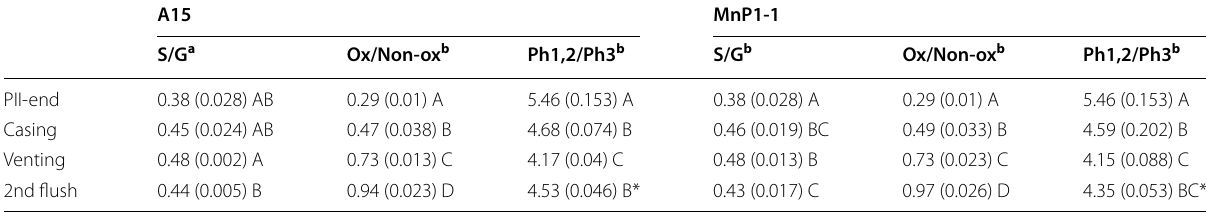
Table 1 S/G, Ox/non-Ox, and Ph-C1,2/Ph-C3 ratios in compost colonized by strain A15 or MnP1-1